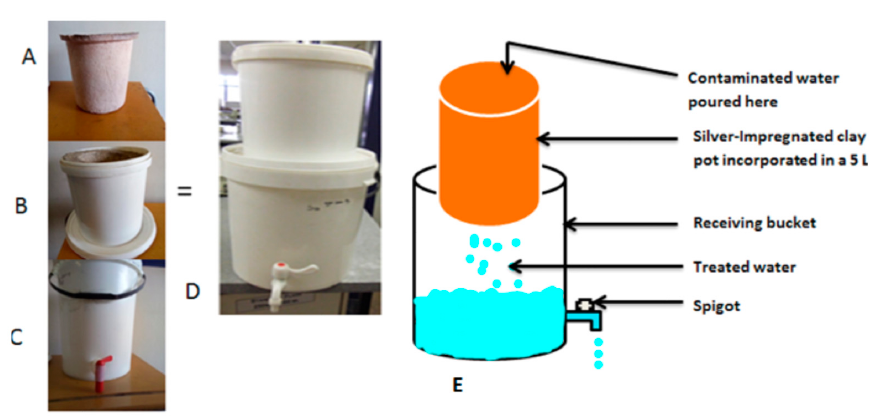
Figure 2. ( A ) Silver-impregnated porous pot (SIPP) filter; and ( B ) 5 L bucket with silver impregnated clay pot inside; ( C ) 10 L receiving bucket; ( D ) Complete SIPP filter; and, E - schematic representation of SIPP filter.